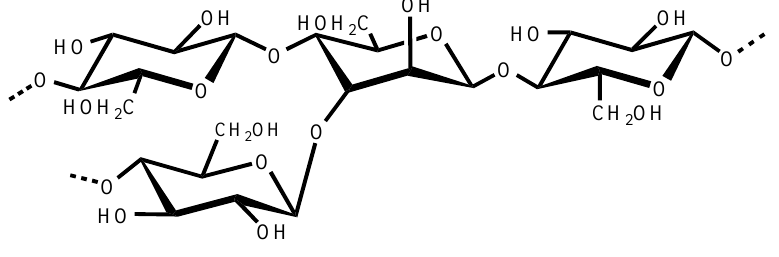
Figure 1 . The chemical structure of konjac